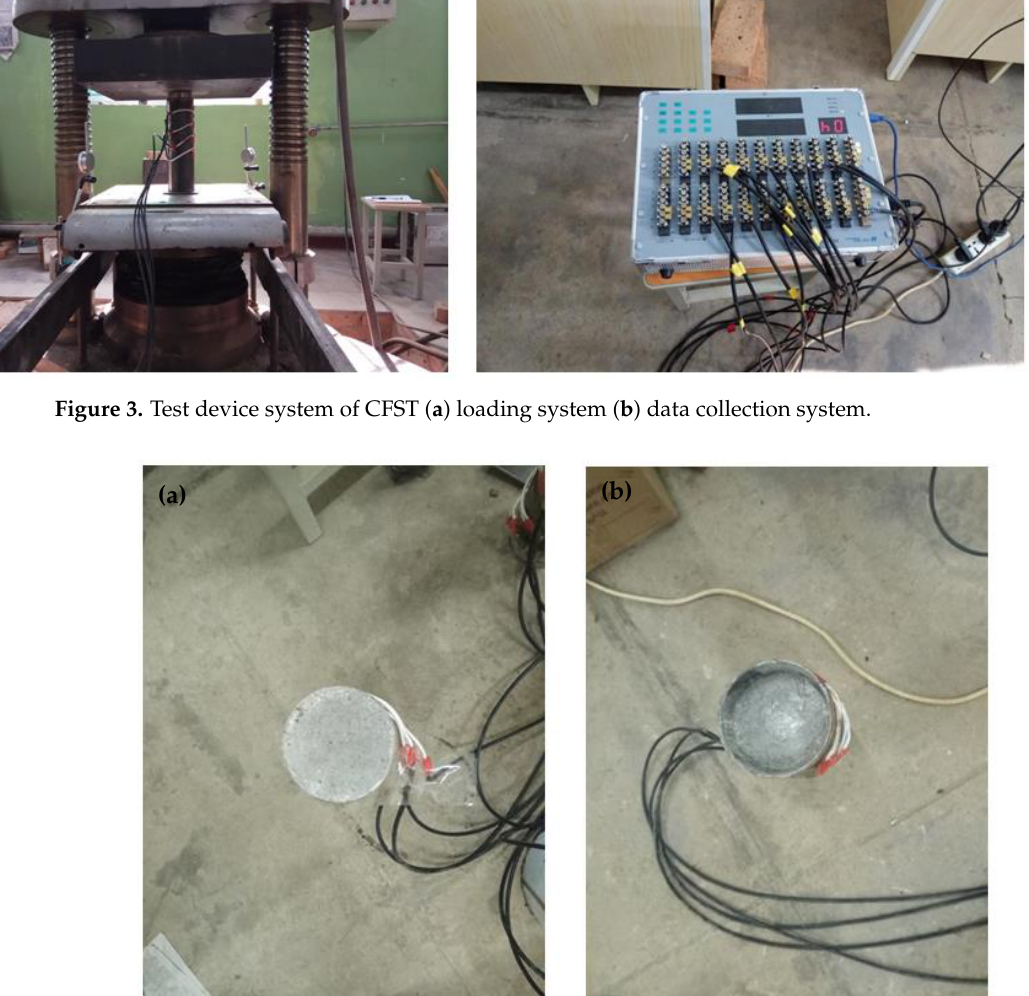
Figure 4. Comparison of CFST specimen ( a ) before loading ( b ) after loading . Table 7. Test results of